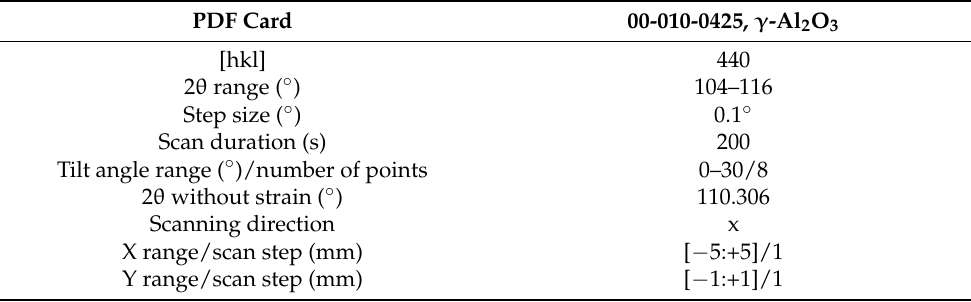
Table 3. Residual stress scan parameters.